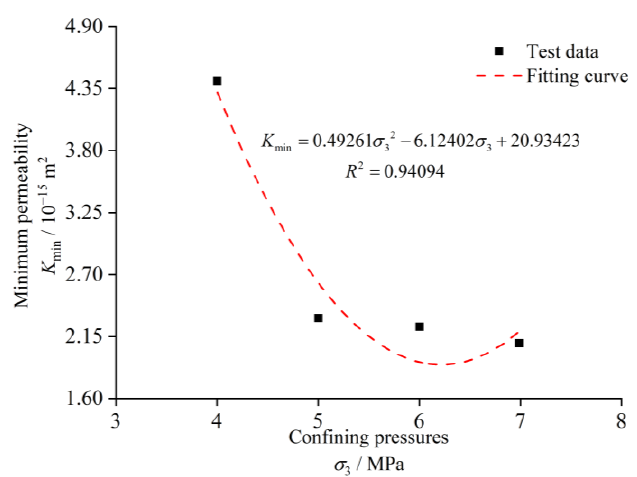
Figure 11. Variation curve of minimum permeability of coal sample under axial compression loading with a constant gas pressure of 1.5 MPa and different confining pressures.